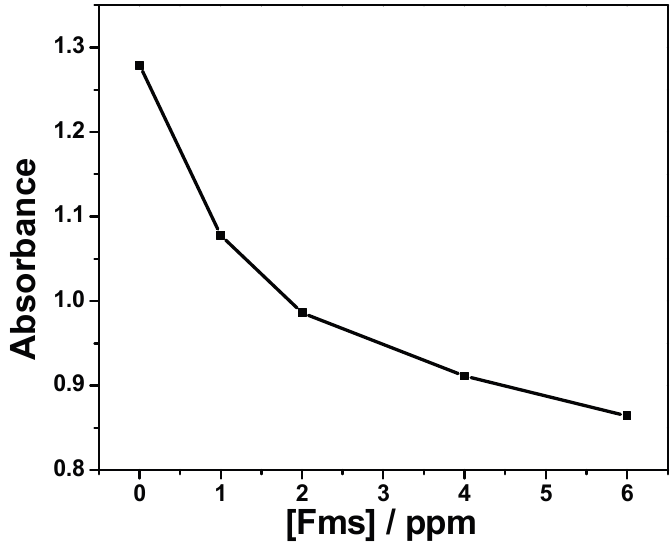
Figure 12. Detection of fumonisin standards curve by enzyme-linked immunosorbent assay